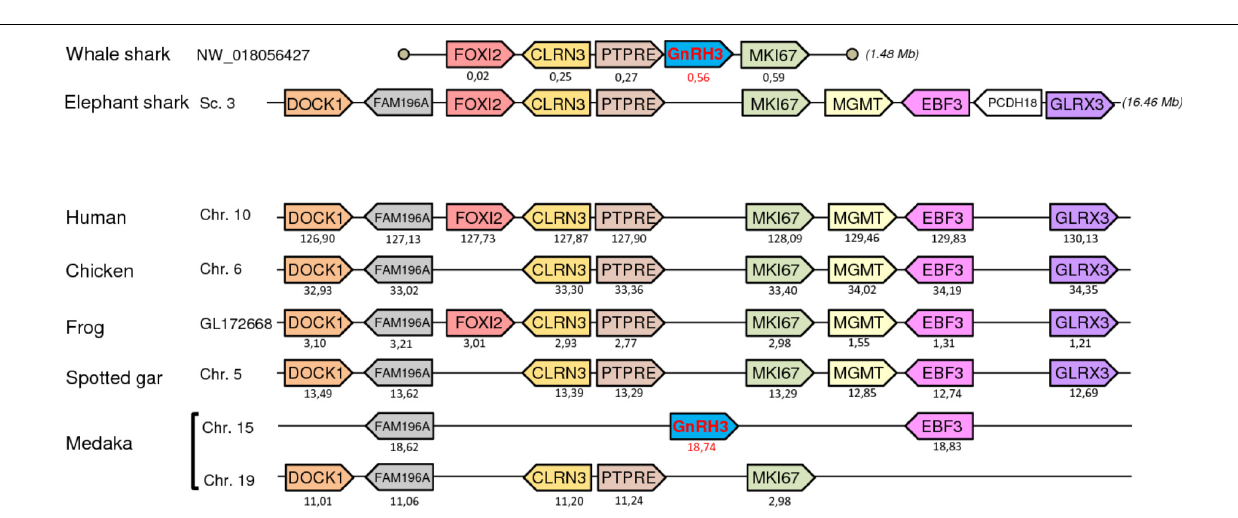
FIGURE 6 | Synteny of genes in the GnRH3 locus in catshark, whale shark, and elephant shark plus five selected bony vertebrate species (human, chicken, western clawed frog, spotted gar, and medaka). Legends are the same as in the Figure 4